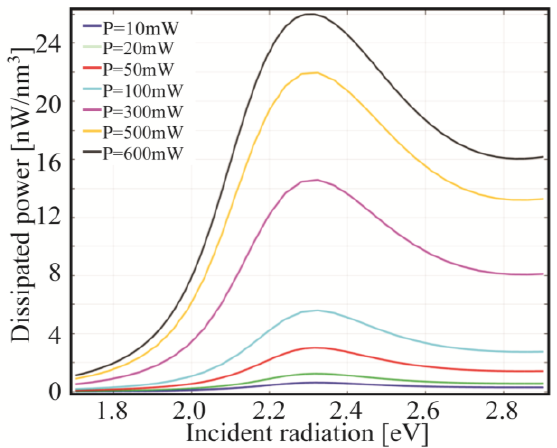
Figure 15. Dissipated power (Joule heating) spectra for a gold nanospheres ( R = 10 nm) embedded in Silica at different incident powers.